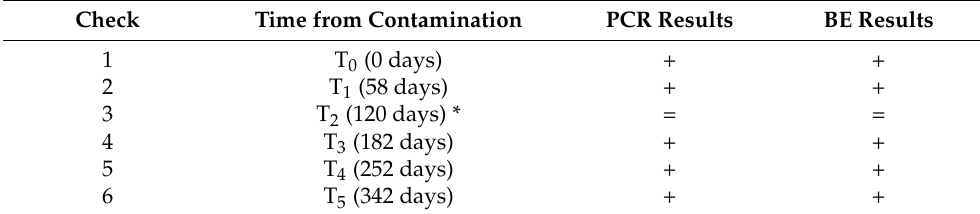
Table 6. Results of the tests related to the fourth experimental